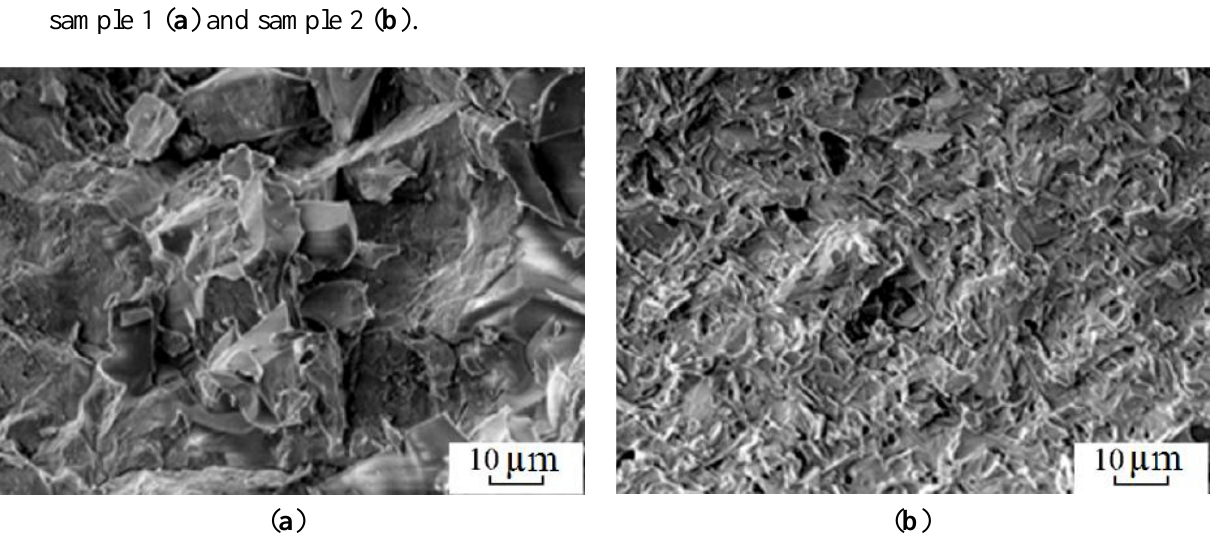
O -SiO mixtures: 2 3 2